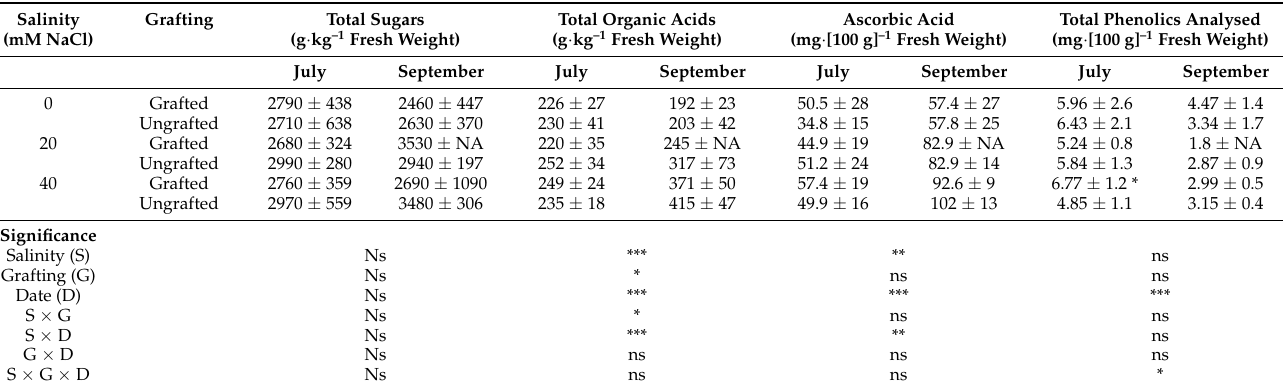
Table 6. Effects of salt stress on the biochemical parameters of the pepper fruit harvested in July and September for ungrafted and grafted bell pepper plants, and their salinity, grafting, and date interactions. Salinity